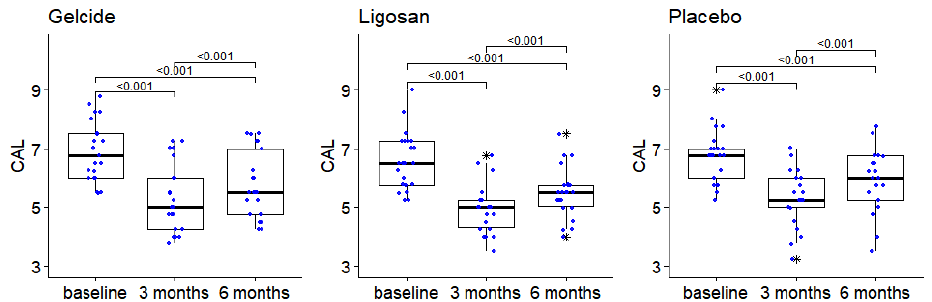
Figure 5. The evolution of the CAL between successive time points in the three groups (numbers in brackets represent p -values of Wilcoxon tests for pairwise intragroup comparisons; p -values > 0.05 are not displayed), boxplot depicts median and interquartile range, large stars represent outliers; data points displayed as superimposed dot plots.